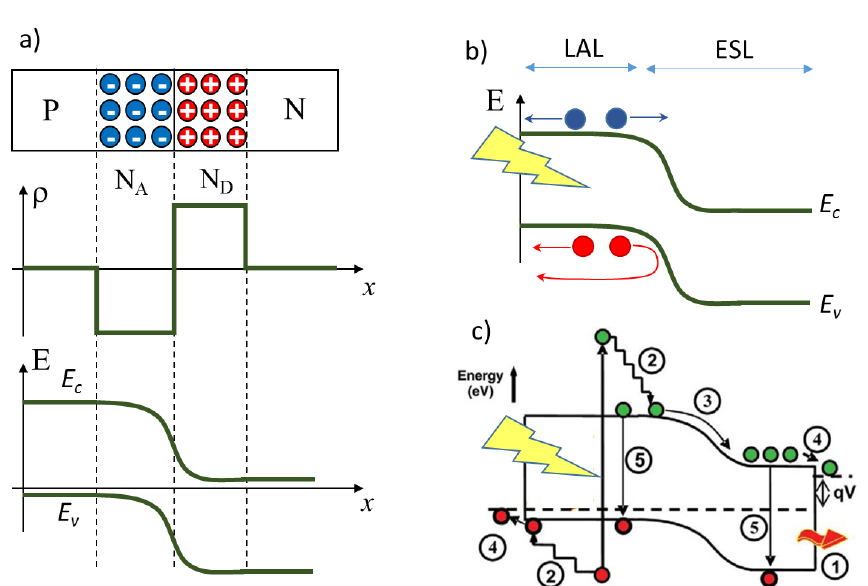
Fig. 3. – (a) p-n junction and band alignment. Schematics of a p-n junction representing the distribution of charge after the thermal equilibrium and the formation of the depletion or space charge region ρ . Notice how the area of the two rectangles is the same, meaning the accumulated charge is the same in order to have neutrality of charge within the junction. The conduction and valence band profiles of the p-n junction obtained by aligning the Fermi levels of both sides. (b) Absorbing and selective layers: photon absorbed in the P region can generate electron and holes, but due to the presence of the junction barrier, only electrons can move in the N region. By using the p-n junction we have implemented the LALA/ESL interface. (c) Charge transport and recombination processes after photon absorption. All the different processes which could be involved after illuminating a p-n junction: 1) non-absorption of low energy photons; 2) thermalization of high energy carriers (or Auger recombination); 3) charge drifted to the collection electrode; 4) charge collected at the electrode; 5) non-radiative